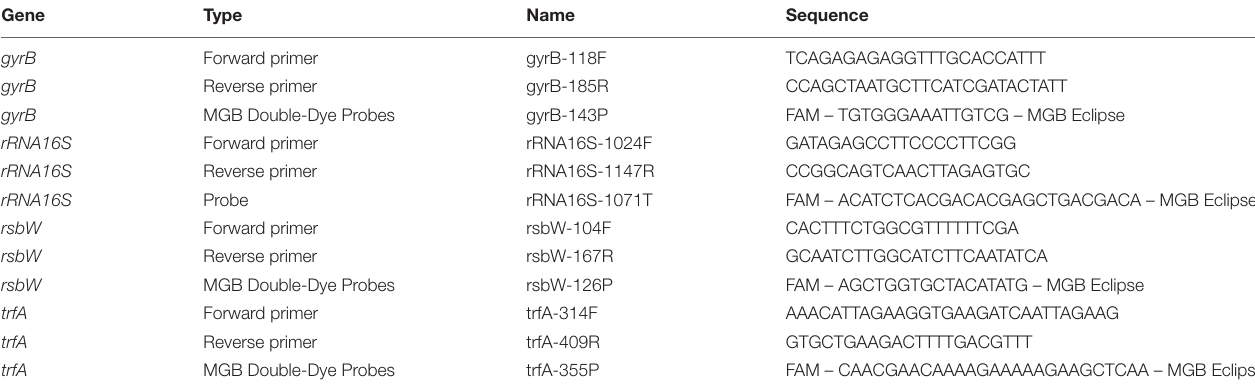
TABLE 2 | RTqPCR primers and probes.